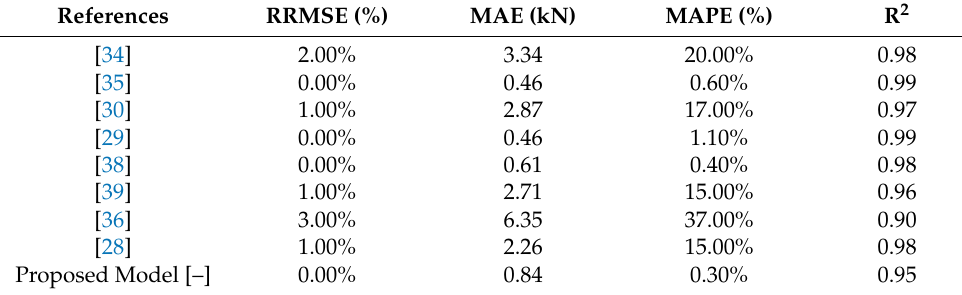
Table 5. Statistical coefficients determination for the considered